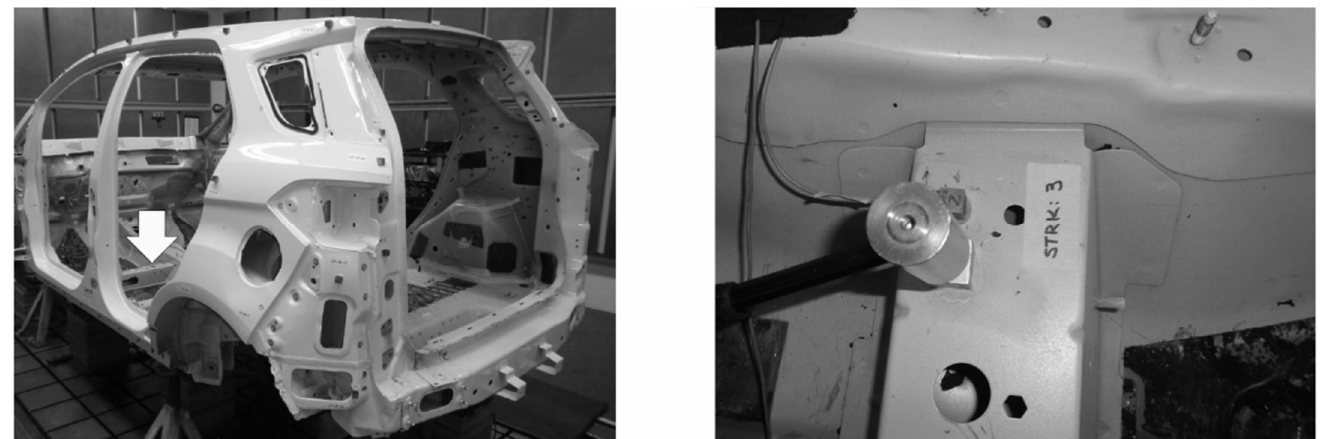
Figure 2. Experimental test body ( left ) and impact hammer load on the front seat attachment ( right